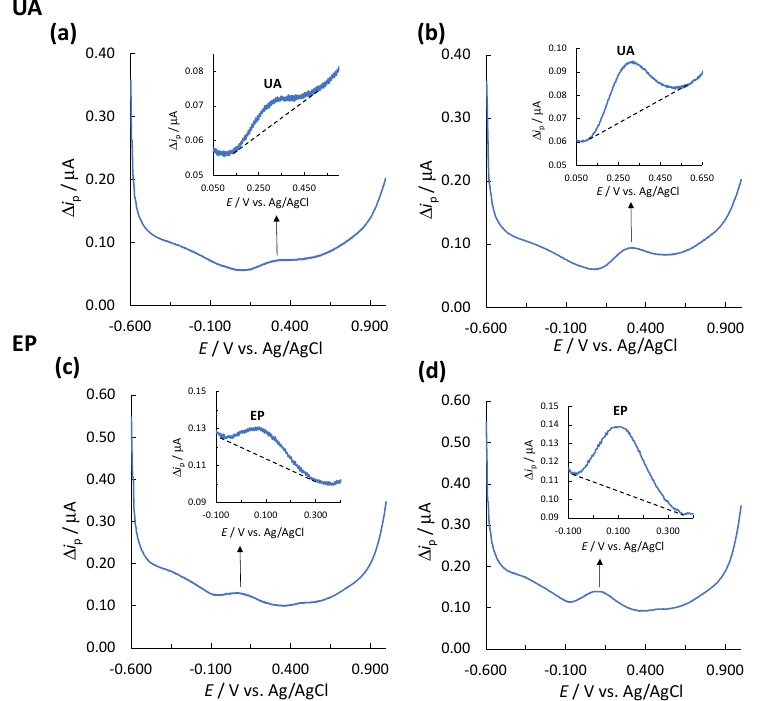
Figure 1. A corresponding voltammogram for the determination of ( a ) LOD for UA, ( b ) LOQ for UA, ( c ) LOD for EP, and ( d ) LOQ for EP.